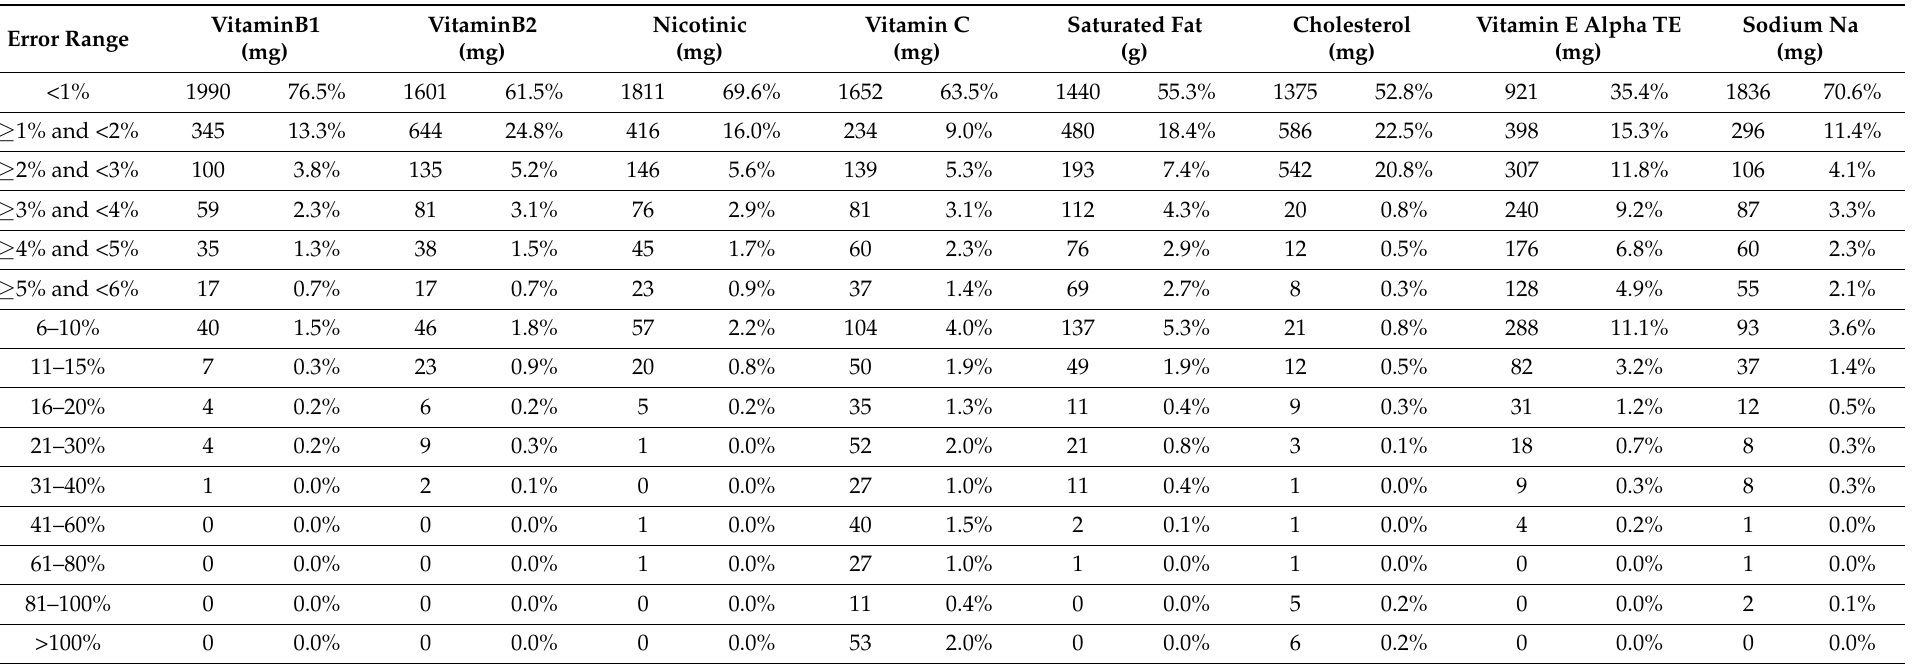
Table 2. Discrepancy comparison table of NNHS analysis with the results of this study in the sum_nutrients_24h